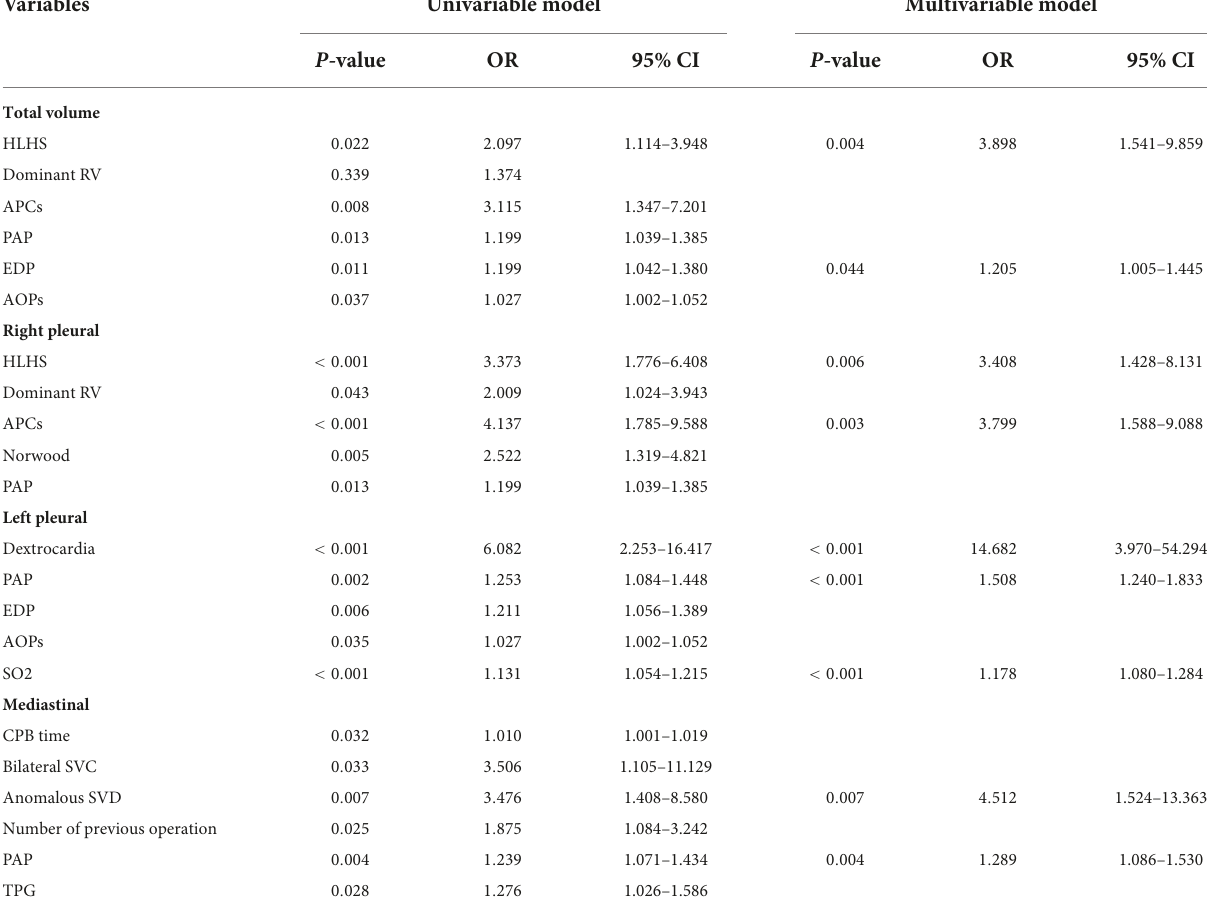
TABLE 3 Factors associated with excessive volume of drainage.